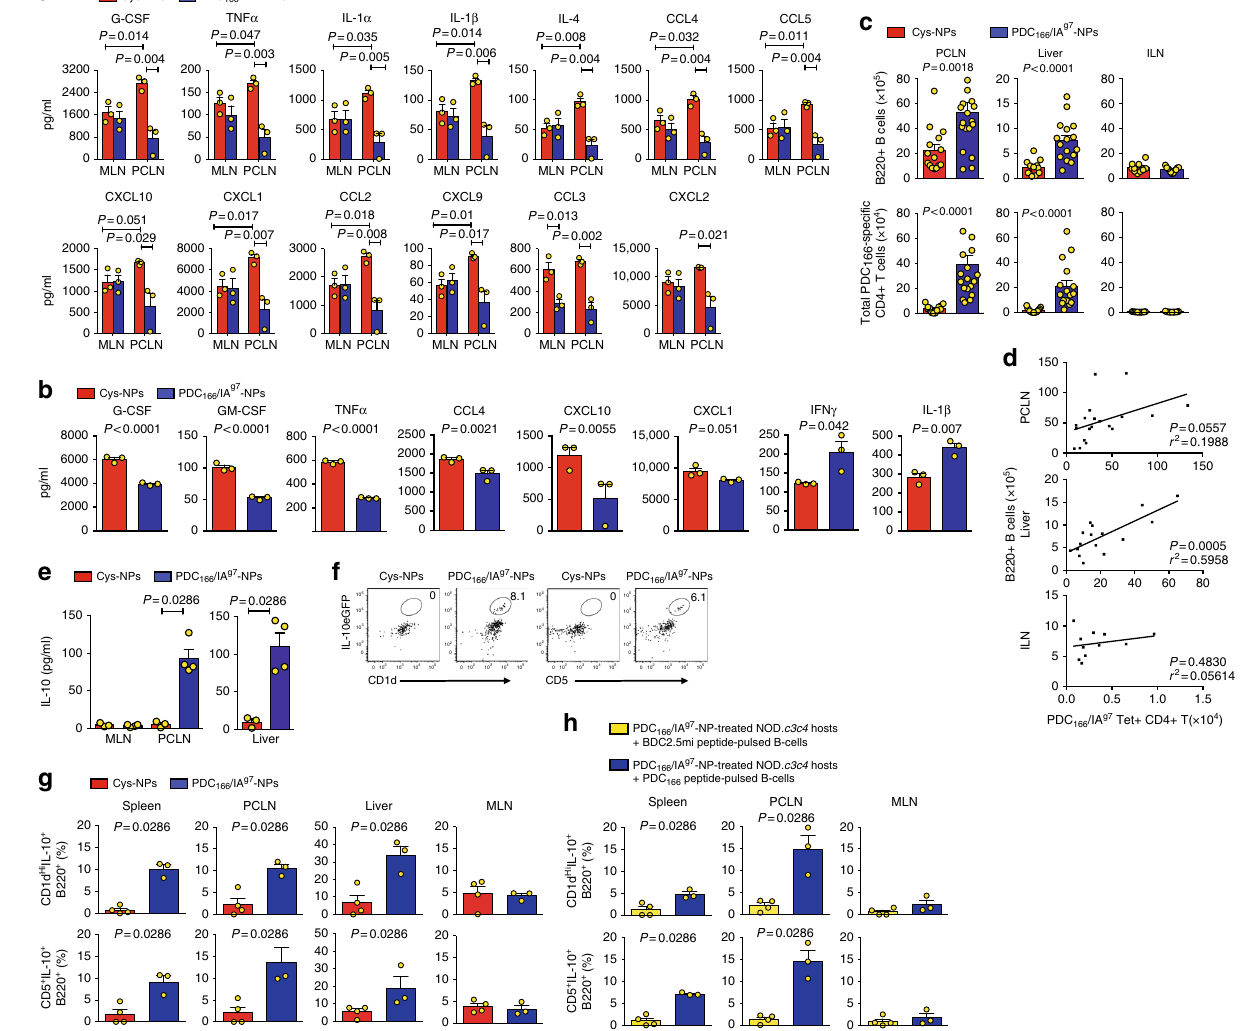
Fig. 5 Liver-speci fi c regulatory network formation. a Cytokine pro fi le of LPS-challenged CD11b + cells from PCLNs and MLNs. b Cytokine pro fi le of Kupffer cells (only statistically signi fi cant analytes shown in a and b ) ( n = 3/group). c Absolute numbers of B-cells (top) and tetramer + T-cells (bottom) in PCLNs, ILNs, and liver. Data for B-cells correspond to n = 15 and 19 (PCLN), n = 11 and 11 (ILN), and n = 12 and 16, respectively (liver), from 3 – 5 experiments/ organ. Data for tetramer + cells correspond to n = 14 and 19 (PCLN), n = 11 and 11 (ILN), and n = 15 and 16, respectively (liver), from 3 – 5 experiments/ organ. d Correlation between numbers of B-cells and tetramer + cells in the PCLNs, liver, and ILNs of PDC 166 – 181 /IA g7 -NP-treated mice ( n = 19, 16 and 11; 4, 5 and 3 experiments, respectively). e IL-10 secretion by LPS-challenged B-cells from PCLNs, MLNs, and liver ( n = 4 and 3 mice/treatment type, respectively). f Representative FACS plots showing conversion of eGFP – B cells from NOD. Il10-eGFP donors into eGFP + /CD5 + /CD1d hi Bregs in PDC- E2 166 – 181 /IA g7 -NP-treated hosts. g Percentages of B cell-to-Breg cell conversion in PDC-E2 166 – 181 /IA g7 -NP vs. Cys-NP-treated NOD. c3c4 hosts, in liver, spleen, PCLNs, and MLNs ( n = 3 and 4 mice/treatment type, respectively). h Percentages of B cell-to-Breg cell conversion in PDC-E2 166 – 181 /IA g7 -NP- treated NOD. c3c4 hosts, in spleen, PCLNs, and MLNs, as a function of the peptide displayed on the B-cell surface (non-cognate: BDC2.5mi, n = 4/organ; or cognate: PDC 166 – 181 , n = 3/organ). Data correspond to mean ± SEM. P values were calculated via multiple t-test analysis ( a and b ), Mann – Whitney U ( c , e , g and h ) or Pearson ’ s correlation test ( d